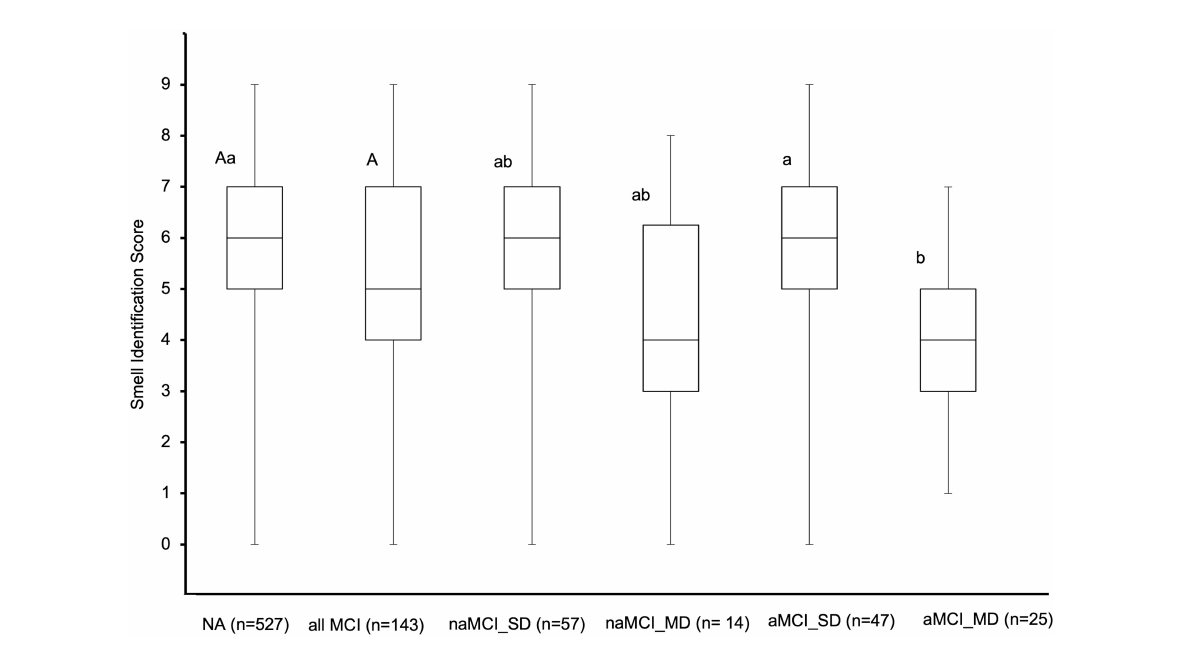
FIGURE4 The measured mean smell identification score of the various cognitive status of 670 older adults. The capital letter “A” above the interquartile ranges denoted no significant difference between NA and total MCI participants (one-way ANOVA, p < 0.05). Different small letters (i.e., a, b) above the interquartile ranges denoted significant differences in mean smell identification scores between cognitive status. The first and second letters in the superscripts (e.g., “Aa” in NA category) show the two independent statistical significant results from a comparison of two groups’ differences (NA vs. all MCI) and five groups’ differences (NA vs. each MCI subtypes), respectively. NA, normal aging; MCI, mild cognitive impairment; naMCI_SD, non-amnestic MCI single domain; naMCI_MD, non-amnestic MCI multiple domain; aMCI_SD, amnestic MCI single domain; aMCI_MD, amnestic MCI multiple